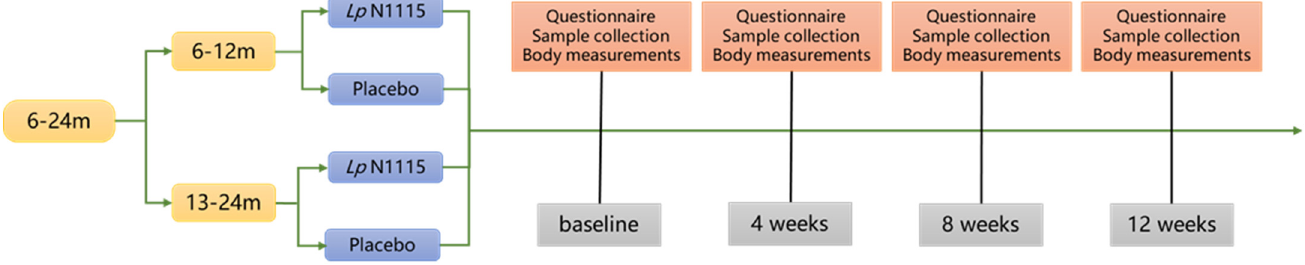
Figure 1. Experimental procedure.